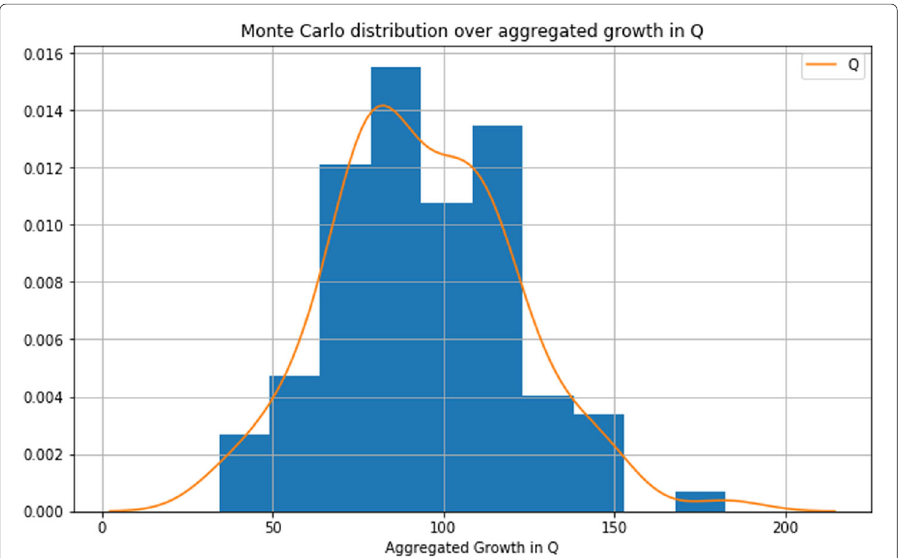
Fig. 7 Distribution of aggregated growth in Q over 100 Monte Carlo Runs under smooth exponential decay block reward